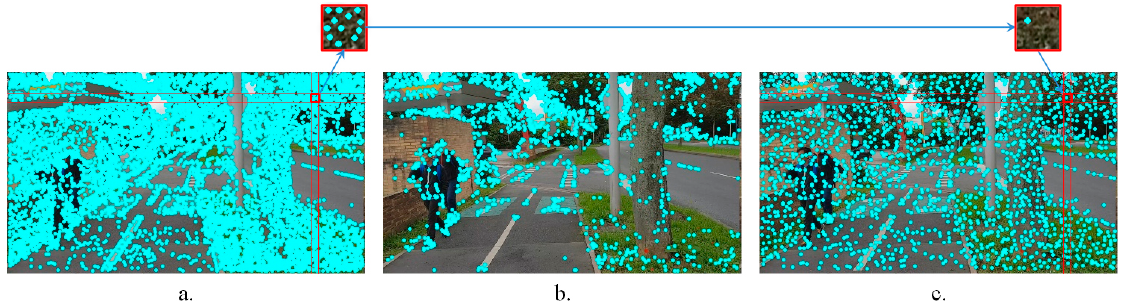
Figure 3. Confident point of interest selection using: ( a ) The traditional FAST algorithm; ( b ) The method introduced in [23]; ( c ) The proposed filtering strategy.